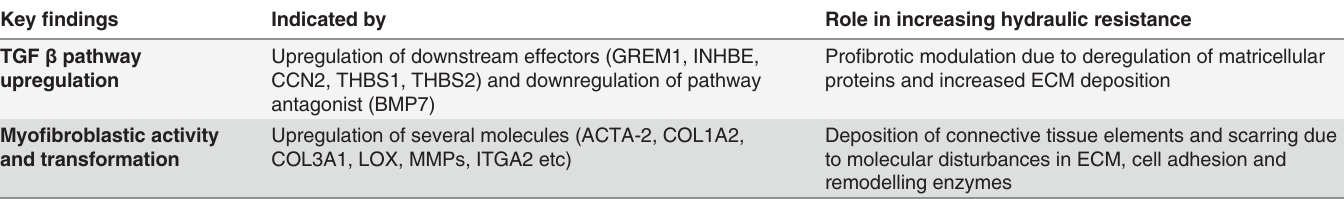
Table 4. Key processes implicated in AGV failure. Key fi